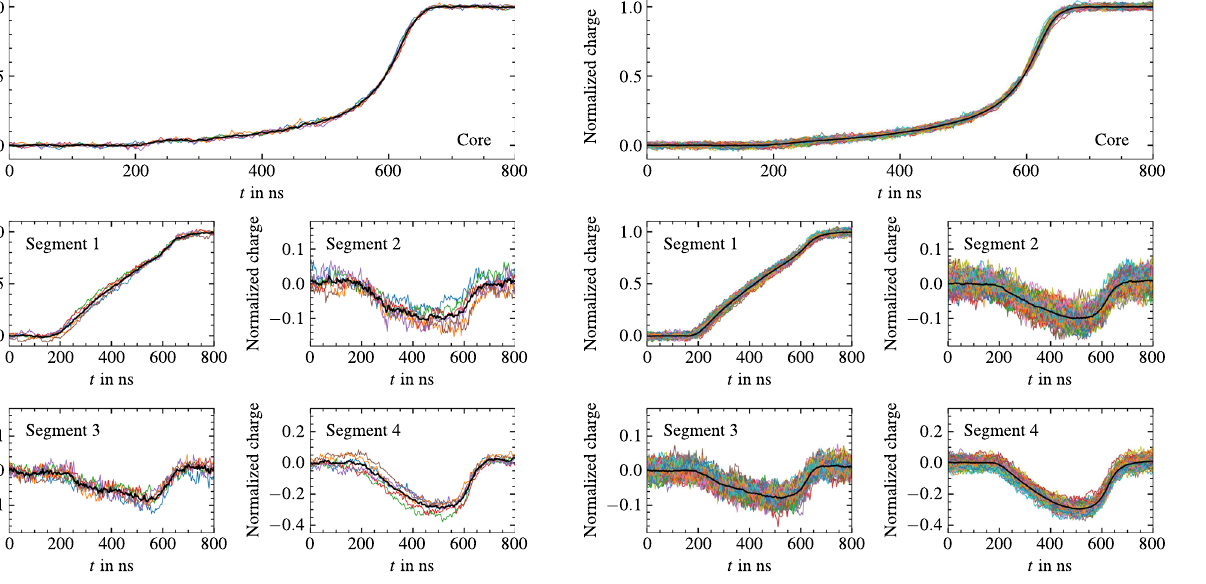
Fig. 14 Pulses from events assigned to the interaction point at r = 33 . 5mm, φ = 46 . 1 ◦ andareconstructed z = ( 20 ± 1 ) mm,withtwo hitsinthecameraorwithonehitinthecameraandselectedasdescribed in Sect. 5.3. All pulses are time-shifted such that the core pulses are aligned to 50% of their amplitude. Shown in black are the